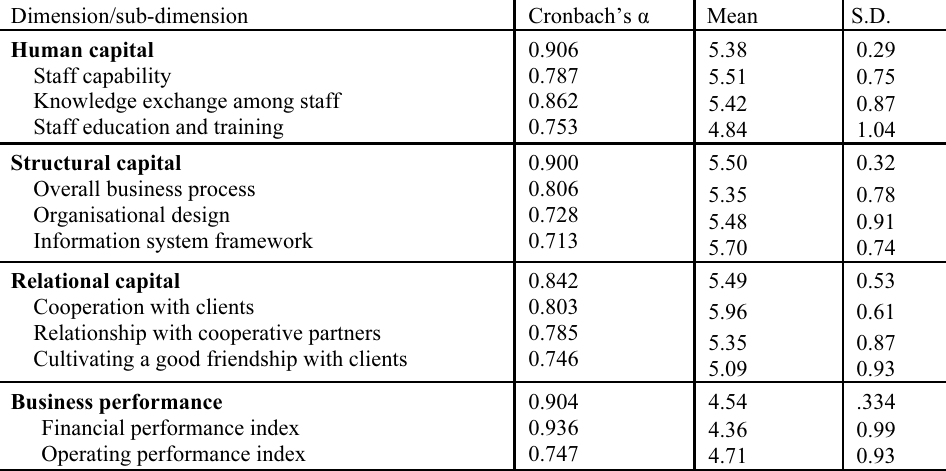
Table 2. Reliability and average score of various sub-dimensions in the scale